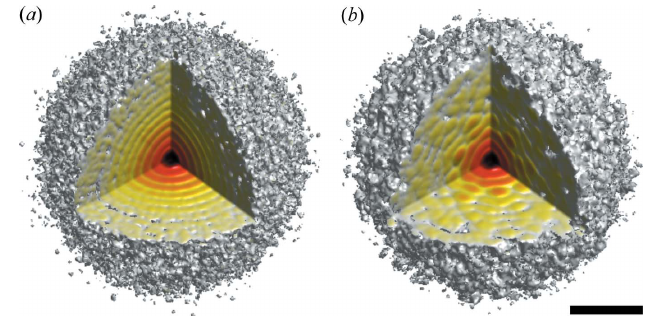
Figure 6 Diffraction 3D intensity volume in reciprocal space: ( a ) 5o6a [for TBEV in Fig. 1( a )]; ( b ) 5o6v [for TBEV with Fab-fragments, Fig. 1( b )]. The scale bar is 1 nm (cid:5) 1